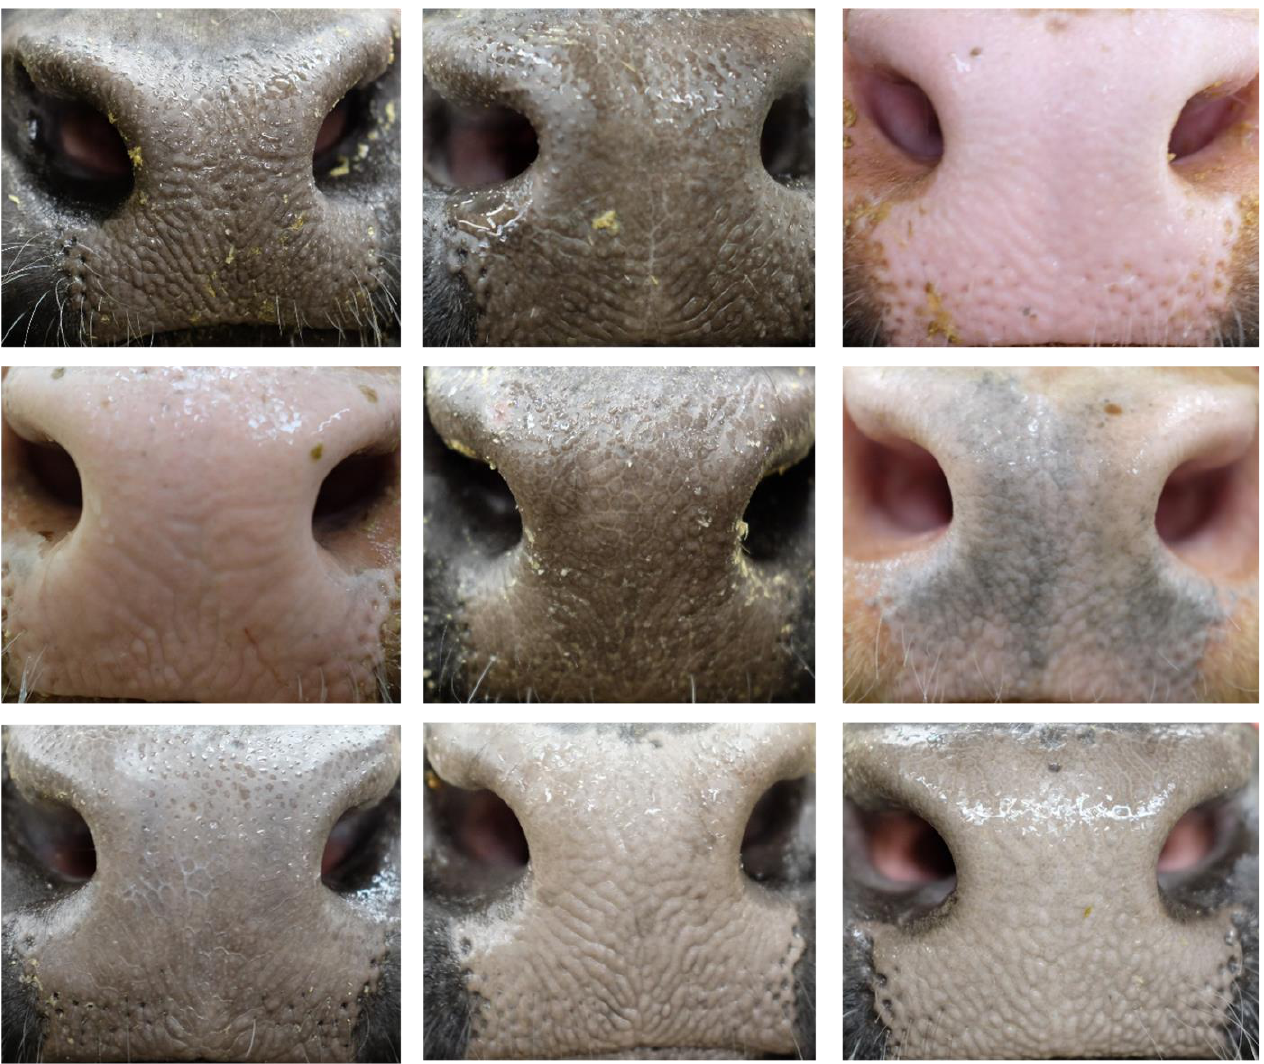
Figure 2. Sample muzzle images of nine individual mixed-breed beef cattle. A frequency distribution of the normalized width/length of cropped images is de- picted in Figure 3. Inconsistent image sizes may lead to biased detection performance, while high-resolution (large-size) images can downgrade the processing efficiency